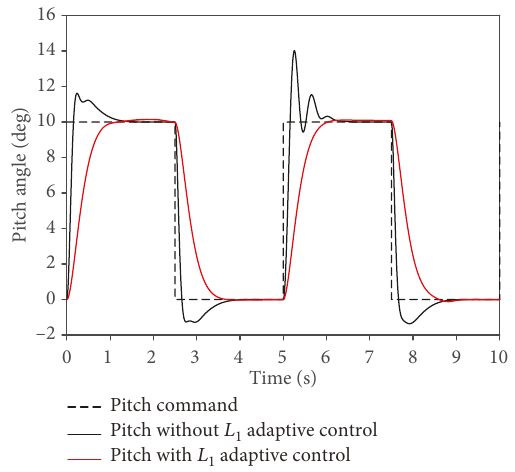
Figure 4: Pitch angle capture task with parameter perturbations.